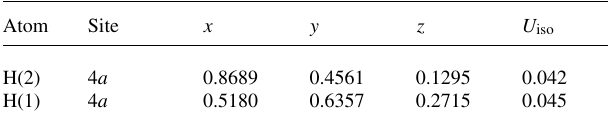
Table 2. Atomic coordinates and displacement parameters (in Å 2 )